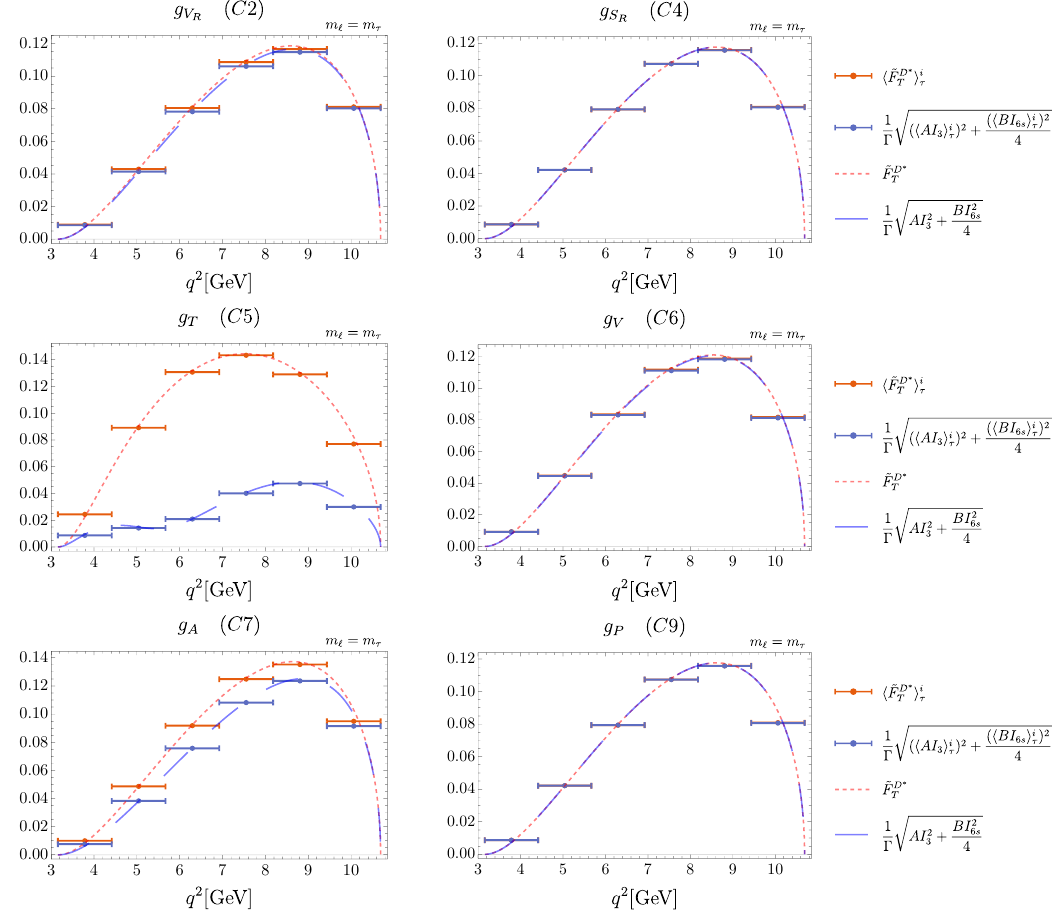
Figure 5. Study of binning e(cid:11)ects for eq. (4.18) for benchmark NP scenarios with complex con- tributions.